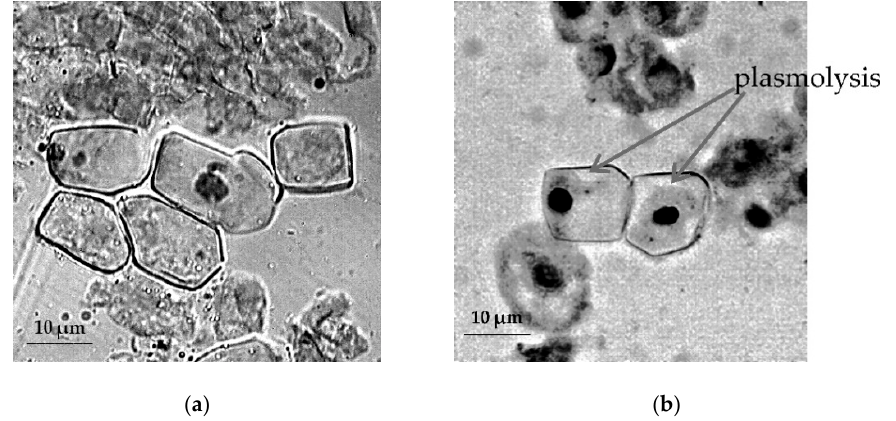
Figure 3. The effect of induced water deficit on root apical meristem (RAM) cells T. monococcum : ( a ), control, ( b ), stress (sucrose, 17.6%, 72 h), scale bar = 10 µm.